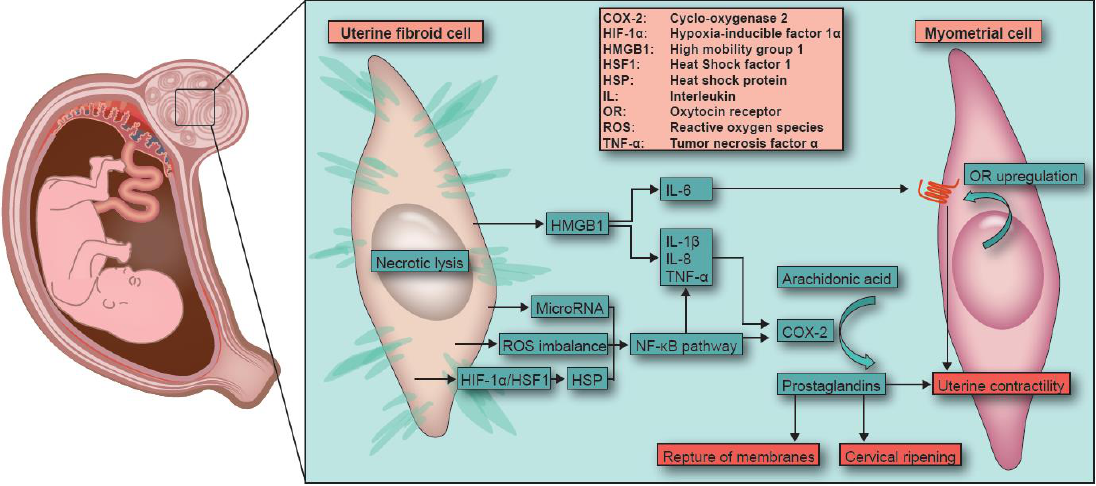
Figure 1. Fibroid necrosis during pregnancy. Schematic representation of the hypothesized inflam- matory pathway of necrosis and induction of pre-term labor in women with fibroid necrosis during pregnancy.